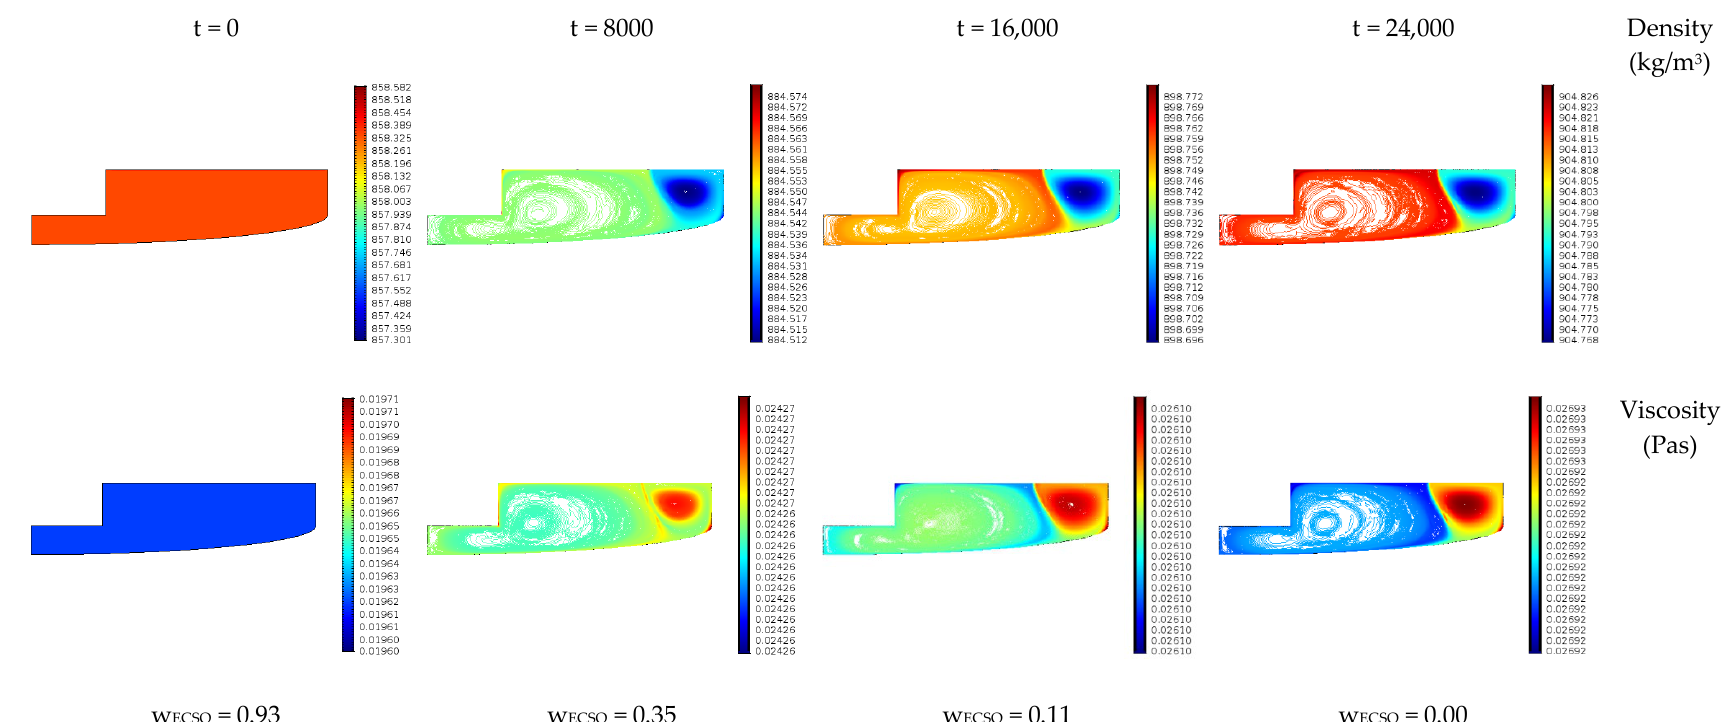
Figure 12. The changes of viscosity and density in time for the optimal solution (and consequently ECSO concentration).